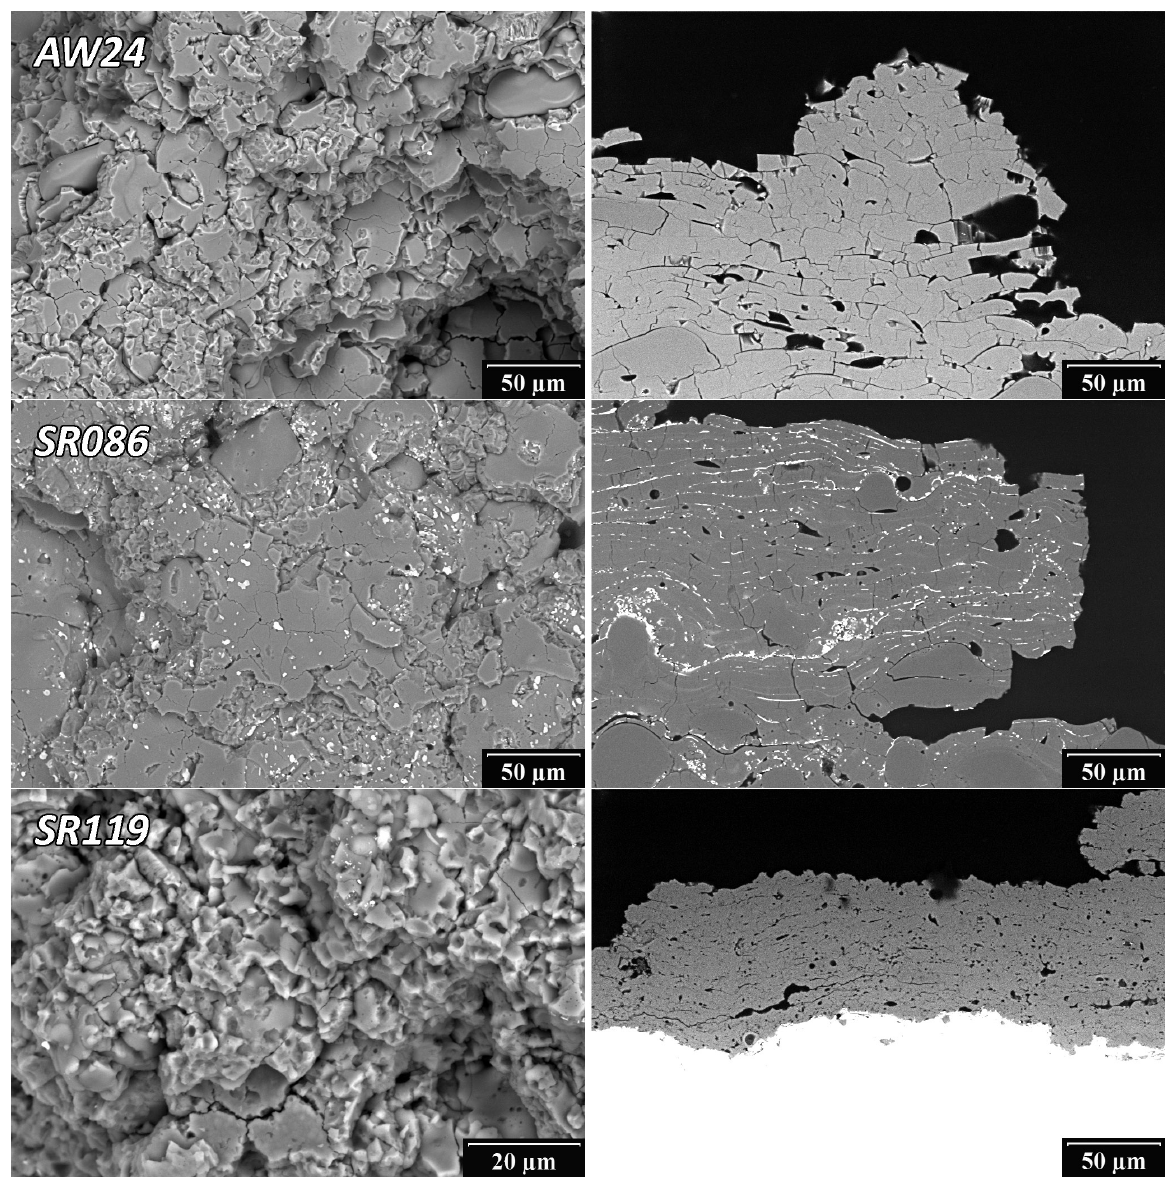
Figure 7. Coating damaged by cavitation. Free-surface (left) and cross-section (right). SEM.